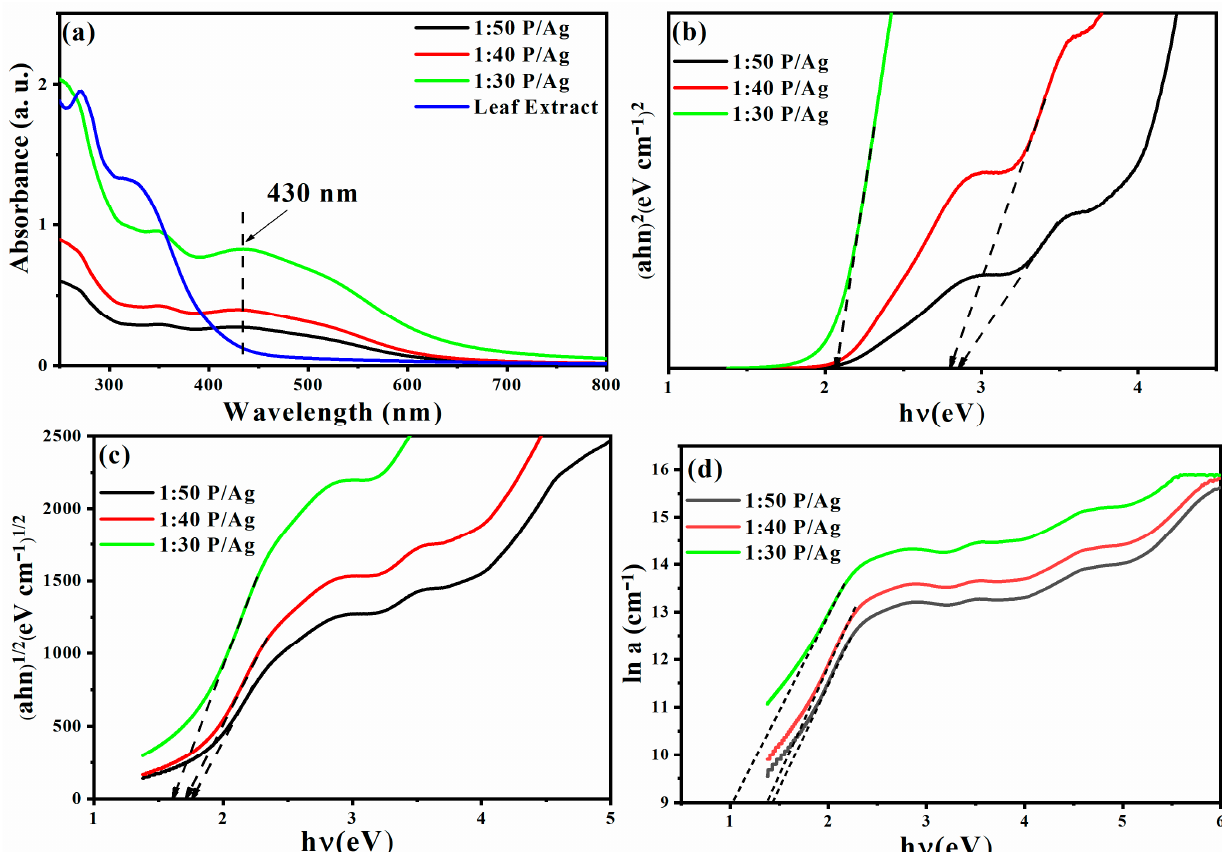
Figure 3. UV–visible spectra ( a ); determination of optical energy gap for direct ( b ) and indirect ( c ) transitions using Tauc’s method; calculation of Urbach energy ( d ) for Ag/Ag 2 O NPs.